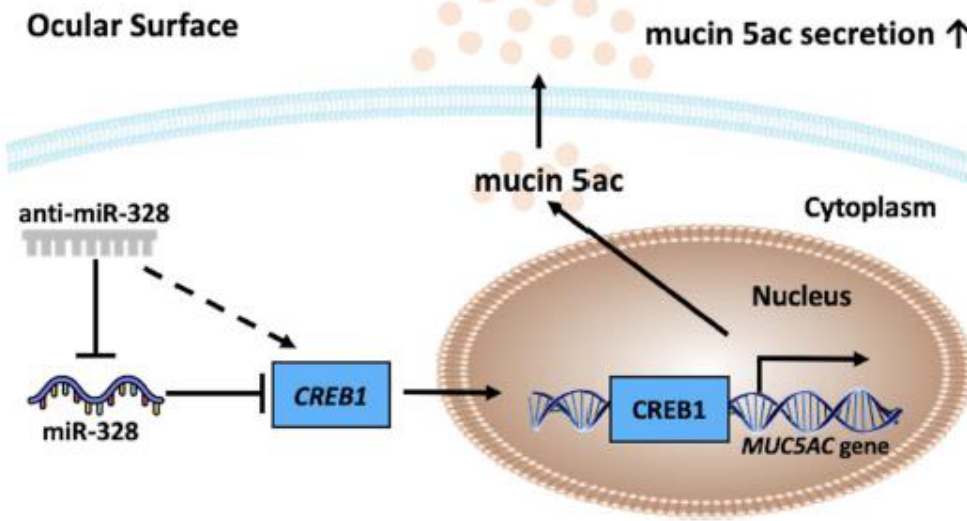
Figure 4. Schematic diagram shows the mechanism of anti-miR-328 for MUC5AC expression.